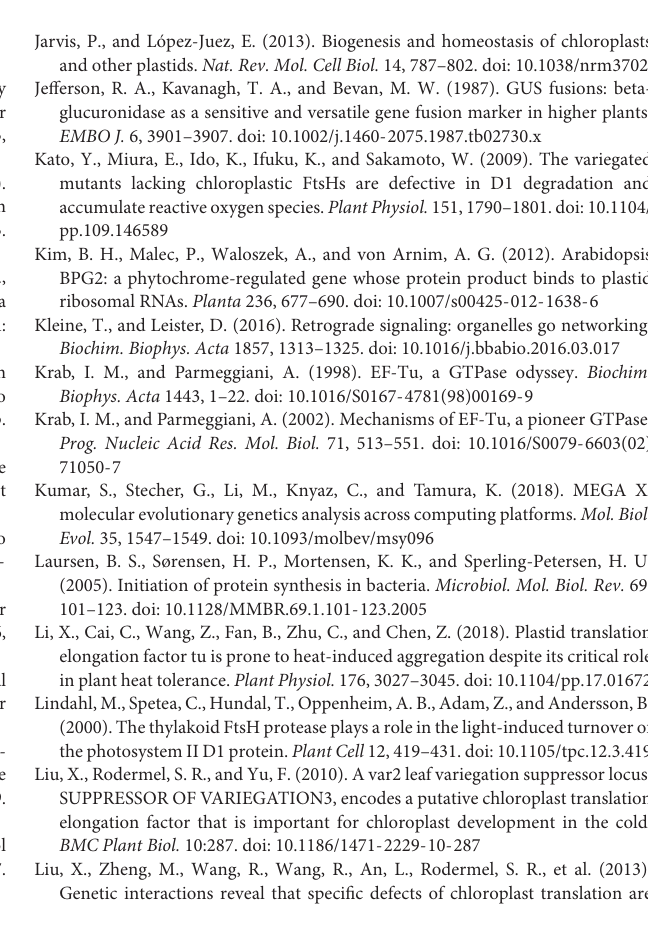
FIGURE S1 | Transient expression of p35S::SVR11-like-GFP fusion protein in leaf protoplasts of plants expressing the mitochondrion marker ScCOX4-mCherry. Representative images of a single protoplast are shown. Bar stands for 10 µ m. FIGURE S2 | Representative seedlings treated with a moderate level heat stress. Eight-day-old seedlings grown at 22 ◦ C were treated at 38 ◦ C for 90 min, and then returned into 22 ◦ C for recovery. After 6 days recovery, seedlings were photographed. FIGURE S3 | Representative 2-week-old seedlings and the corresponding F V / F M images of wild type, svr11-1 , svr9-1 , and the double mutant svr11-1 svr9-1 . The average value of F O , F M , F V / F M were calculated from at least 10 individuals from each